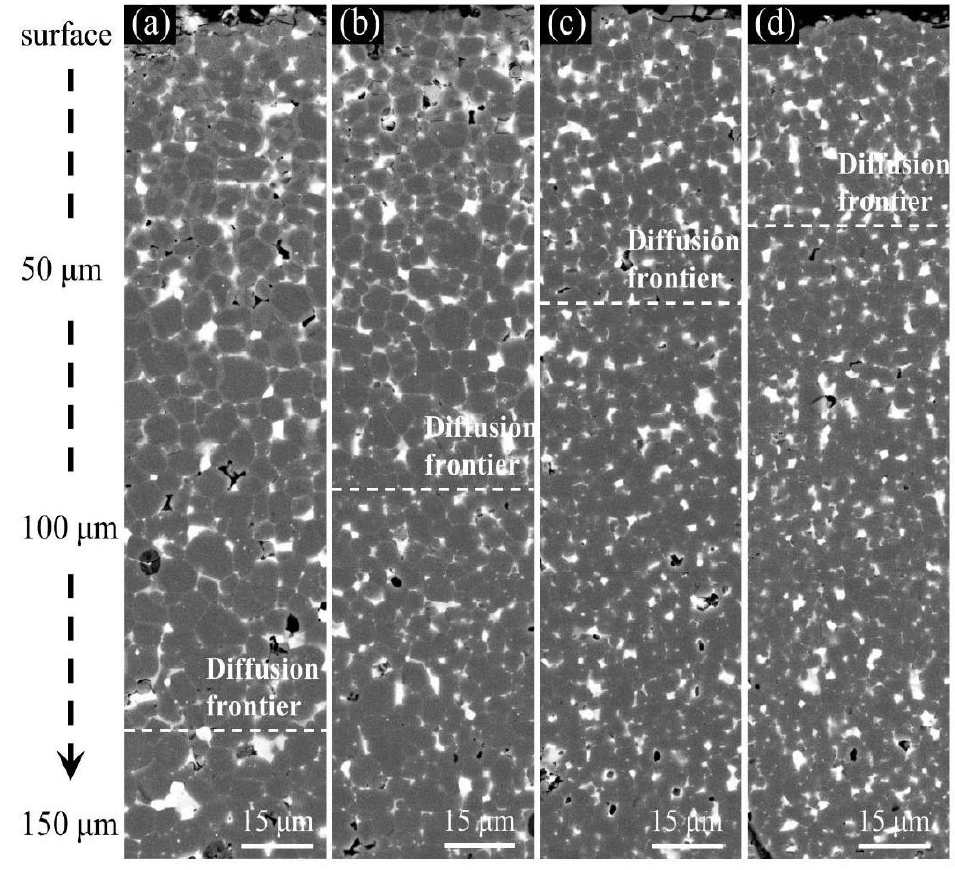
Figure 3. The longitudinal cross-sectional BSE-SEM images of ( a ) G4.9D, ( b ) G4.2D, ( c ) G3.2D, and ( d ) G3.0D diffused magnets. ( d ) G3.0D diffused